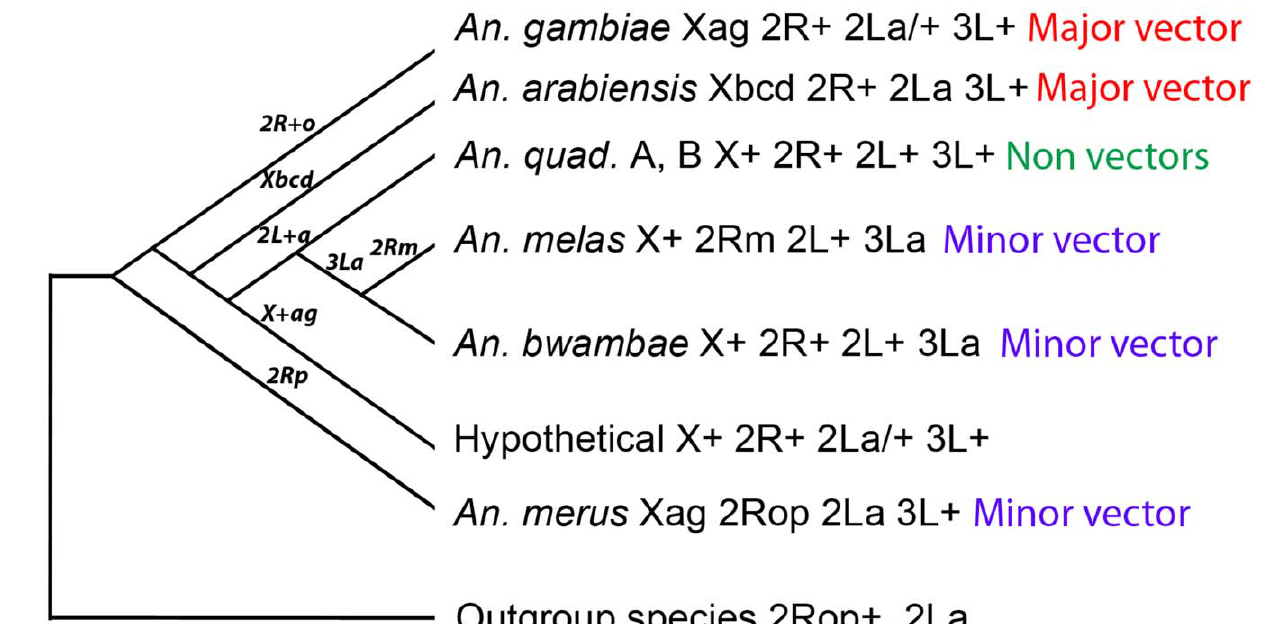
Figure 7. A rooted chromosomal phylogeny of the An.gambiae complex. The phylogeny is based on the ancestry of the 2Ro, 2R + p , and 2La arrangements found in outgroup species. The vector status for each species is indicated. Inversion fixation events are shown above the